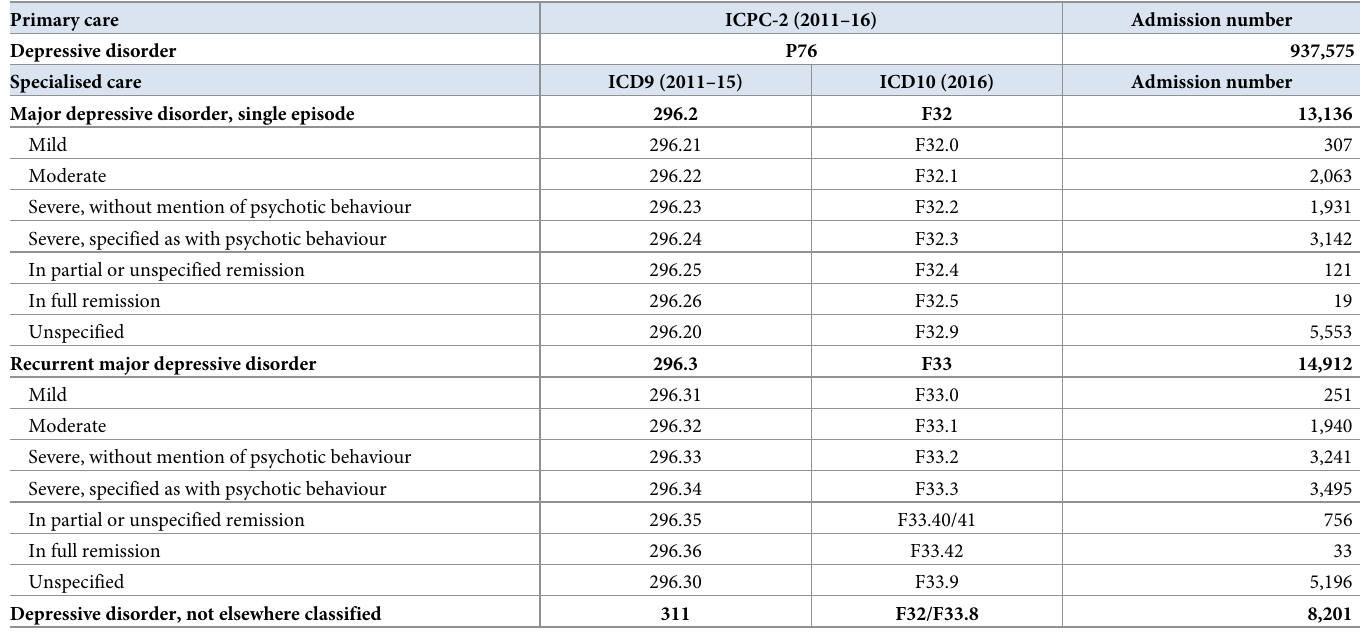
Table 1. Depressive disorders identified according to ICPC-2, ICD9-CM and ICD10-CM codes and number of admissions registered per each